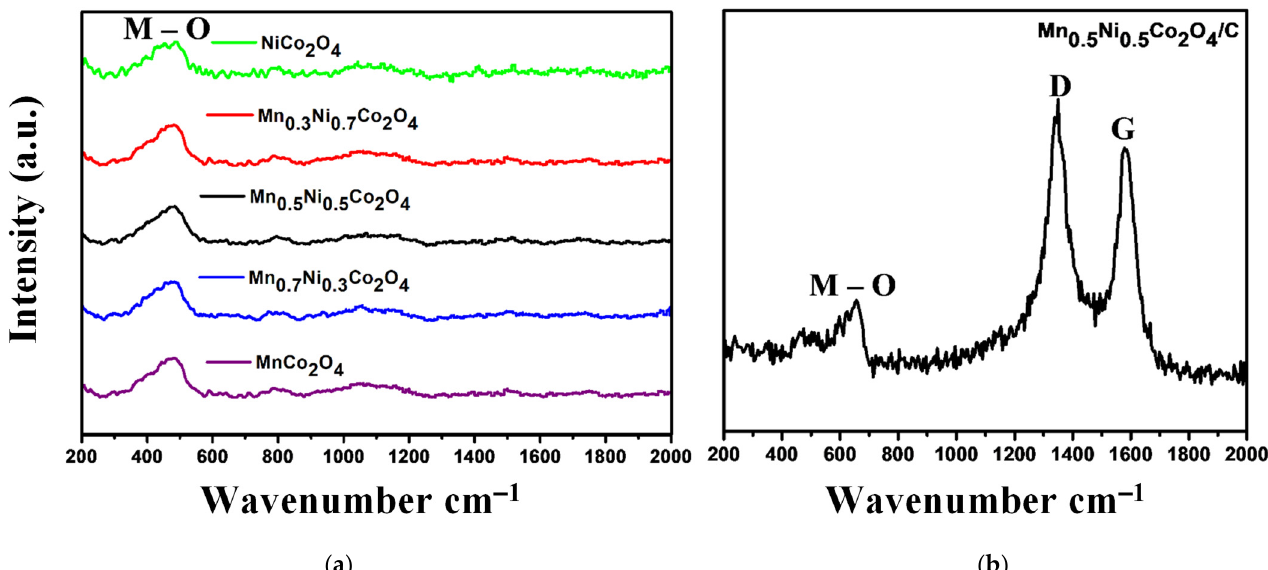
Figure 2. Raman spectrum of ( a ) Mn x Ni 1 − x Co 2 O 4 spinel oxides and ( b ) Mn 0.5 Ni 0.5 Co 2 O 4 /C. The FTIR of the series of Mn x Ni 1 − x Co 2 O 4 spinel oxides (Figure 3) was used to identify the bending and stretching vibrations and give more insight into the spinel formation.